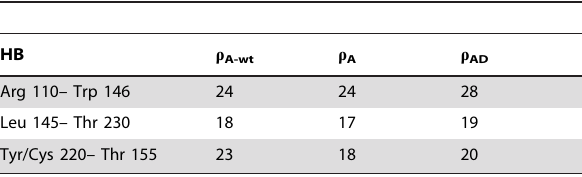
Table 1. Wrapping study of the T-p53C protein molecule (pdb: 1UOL), the T-p53C-Y220C protein (pdb: 2J1X) and the complex between p53C-Y220C and the small molecule PhiKan083 (pdb: